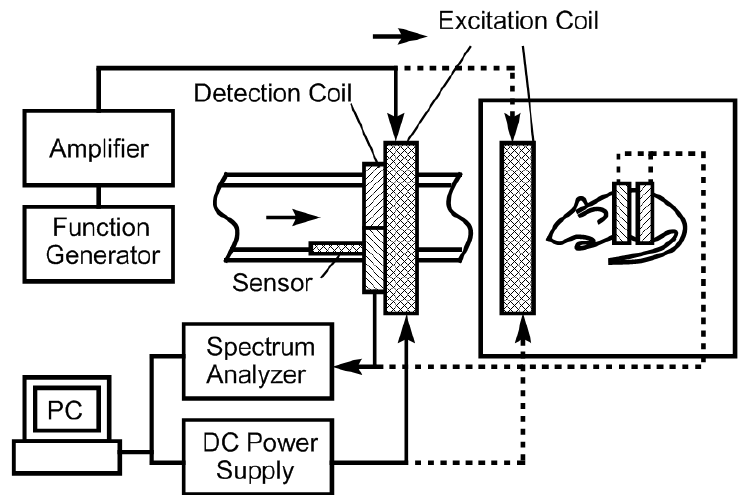
Figure 2. Experimental setup for the sensor evaluation and